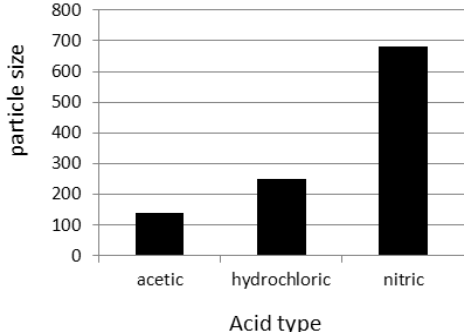
Figure 3. Change in particle size in presence of different